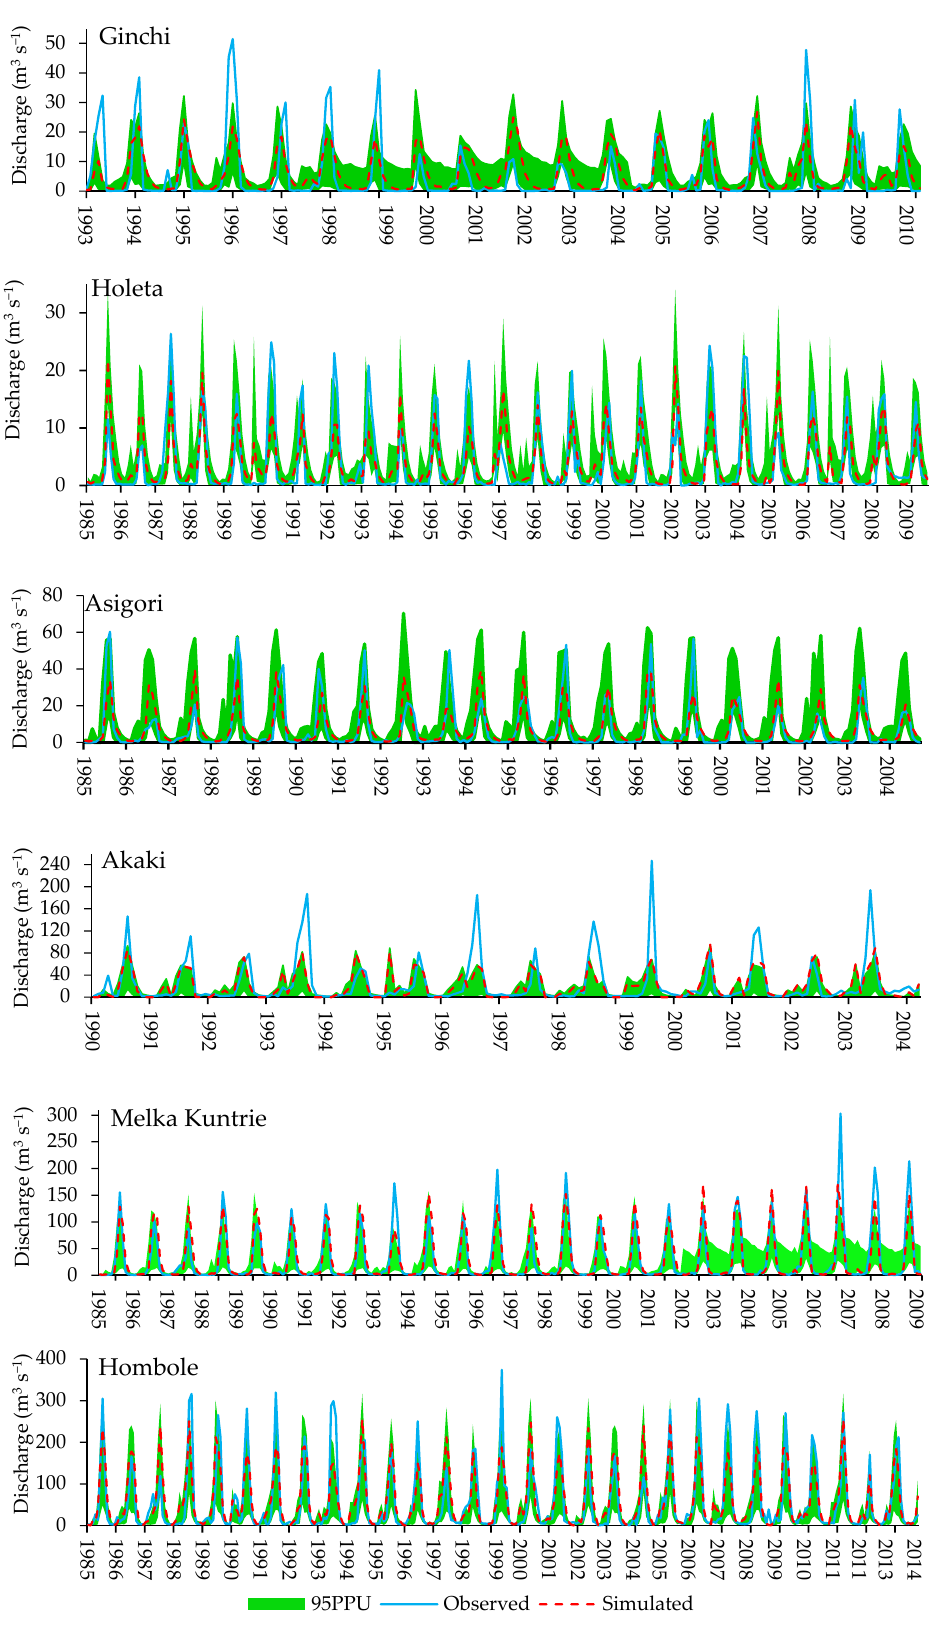
Figure 2. Calibration and validation result for streamflow and each gauging station for the calibration and validation periods. Table 5. SWAT model calibration and validation performance.